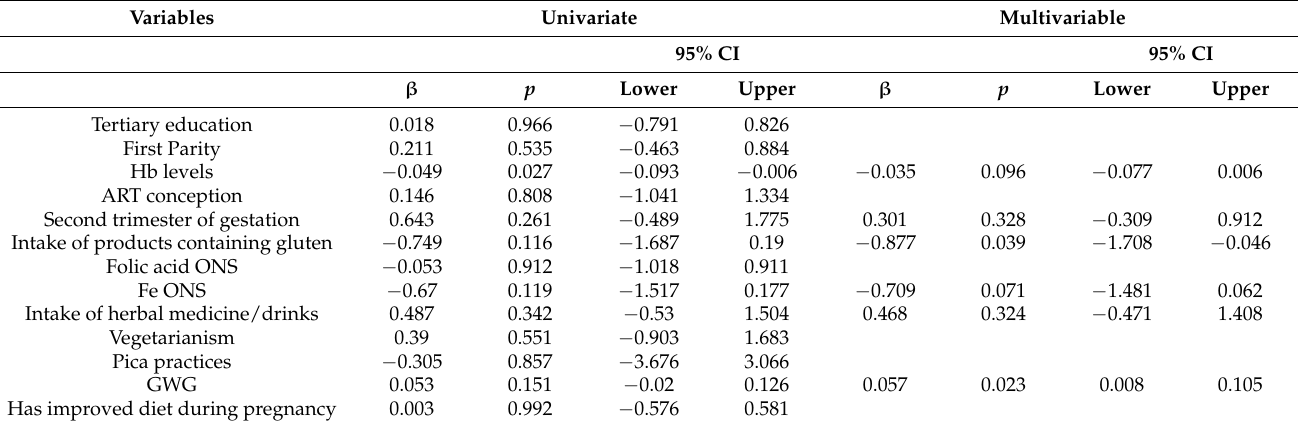
Table 4. Univariable and multivariable logistic regression models explaining